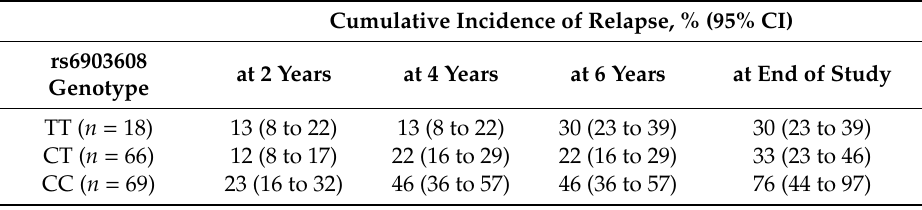
Table 7. Cumulative incidence of relapse at 2, 4 and 6 years of follow up and at the end of the